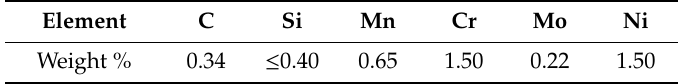
Table 1. Nominal chemical composition of DIN 34CrNiMo6.